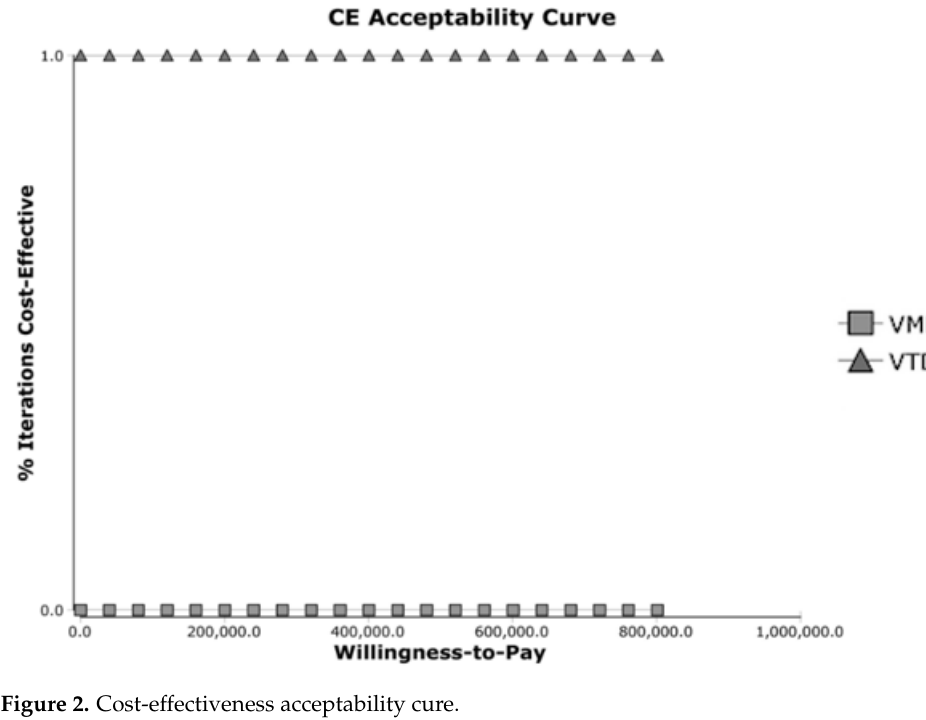
Figure 2. Cost-effectiveness acceptability cure.